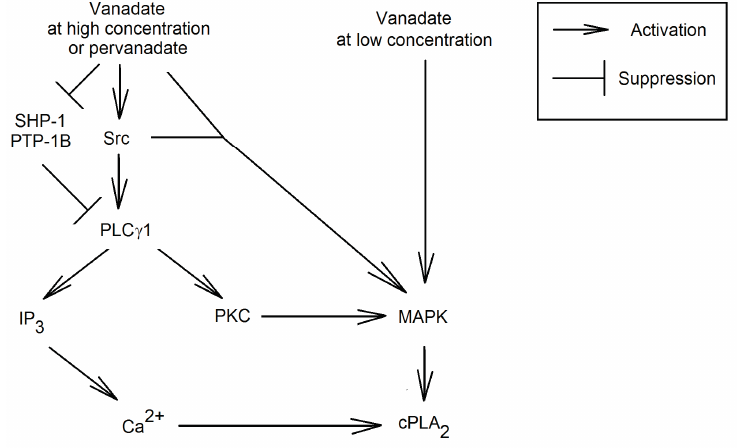
Figure 6. Activation of cPLA 2 by vanadium compounds. Vanadium compounds at low concentrations activates MAPK cascades that phosphorylates cPLA 2 . At higher concentrations of vanadium compounds activate Src, which phosphorylates PLC γ 1. This process causes the release into the cytoplasm of IP 3 , which causes the activation of Ca 2+ channels and the ion influx into the cytoplasm. This PLC γ 1 also activates MAPK cascades. By increasing the concentration of Ca 2+ and the activation of the MAPK cascades is activated cPLA 2